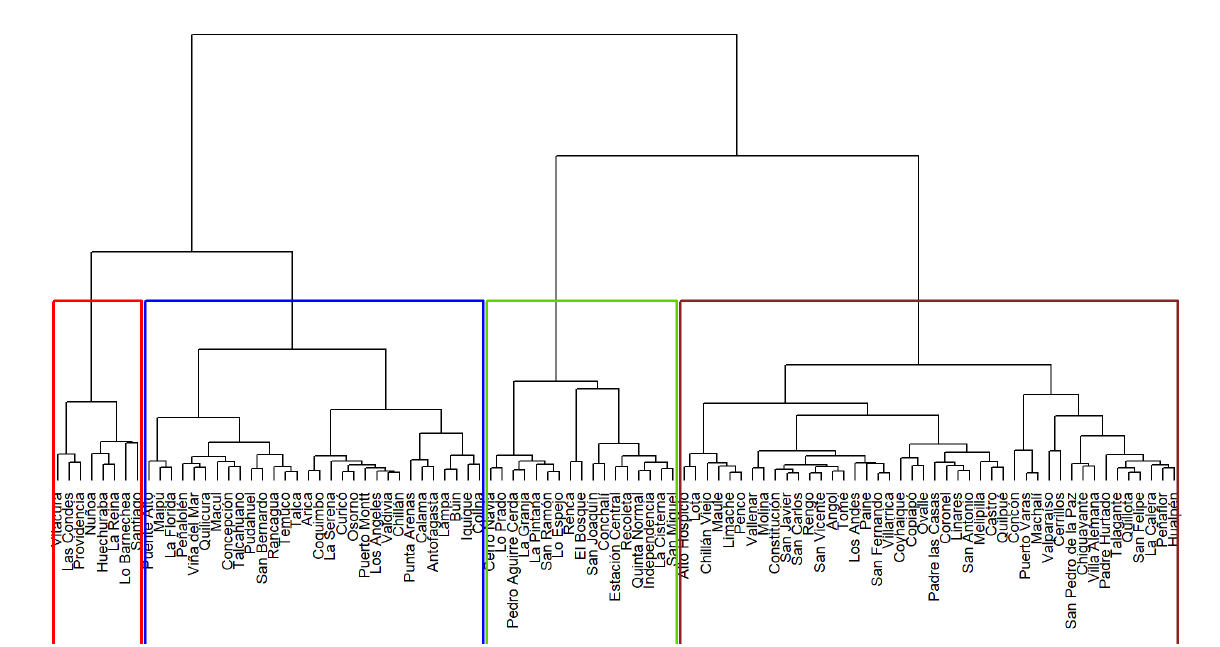
Figure 14. Dendrogram for hierarchical clustering.